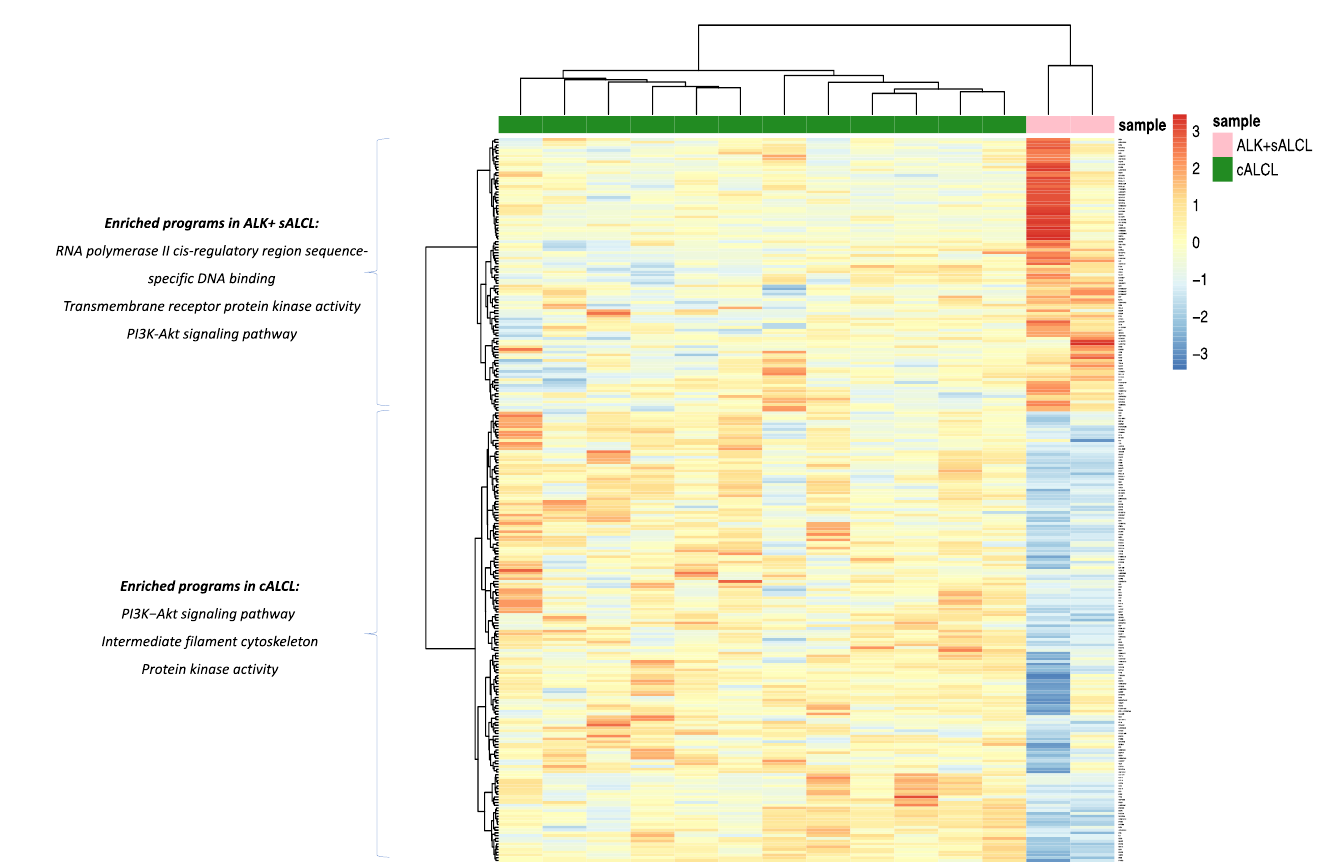
(Table S5). Over-expression of TYK2 due to NPMN1/TYK2 fusion was identified in one of the cALCL cases (Table S6).